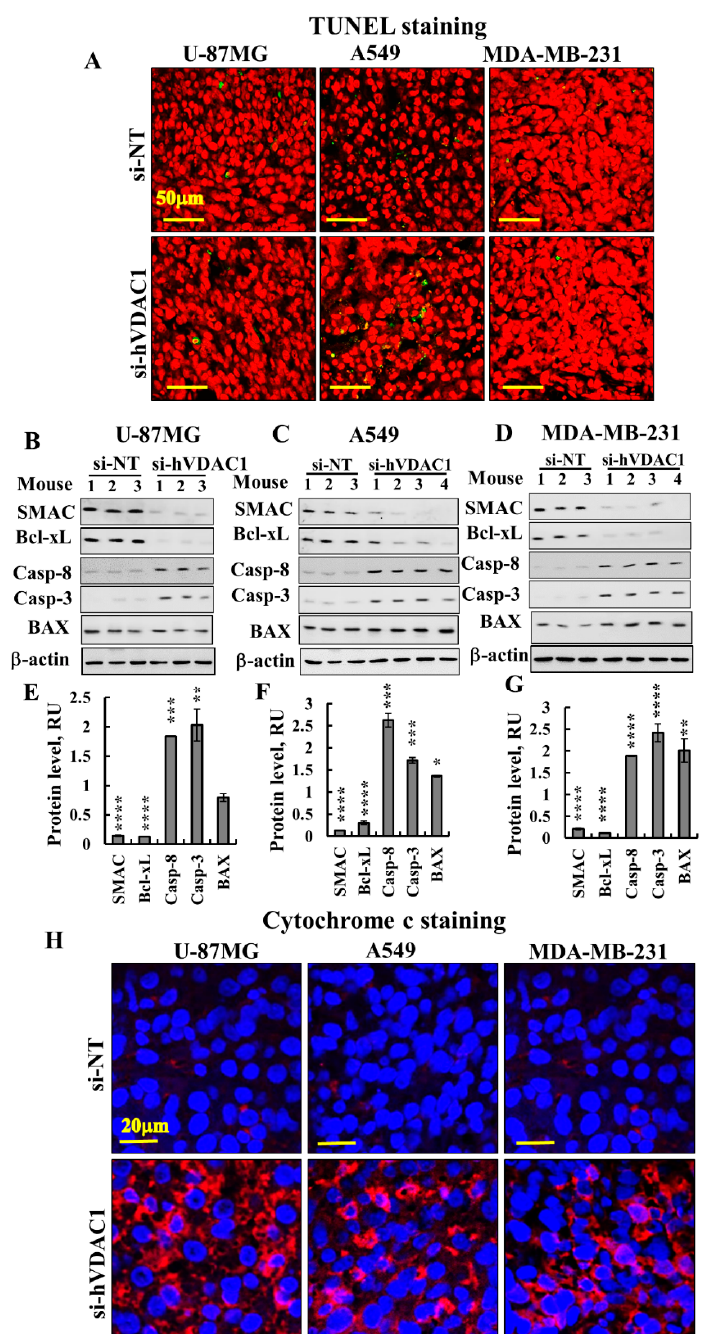
Figure 7. si-hVDAC1 treatment alters the expression levels of SMAC, Bcl-xL, BAX, caspase 8, caspase 3 and cytochrome c in U-87MG-, A549- and MDA-MB-231-derived tumours. ( A ) Representative sections of TUNEL staining of si-NT-TT or si-hVDAC1-TT sections derived from U-87MG, A549 and MDA-MB-231 xenografts. Immunoblots ( B – D ) of SMAC, Bcl-xL, caspase 8, caspase 3 and BAX and their quantitative analysis ( E – G ) in si-NT-TTs and si-hVDAC1-TTs derived from U-87MG ( B , E ), A549 ( C , F ) and MDA-MB-231 ( D , G ) xenografts. Average relative units (RUs) and β -actin as an internal loading control are shown. Results are means ± SEM ( n = 3); p : ** ≤ 0.01; *** ≤ 0.001; **** ≤ 0.0001. ( H ) Representative cytochrome c staining of si-NT-TT and si-hVDAC1-TT sections derived from U-87MG, A549 and MDA-MB-231